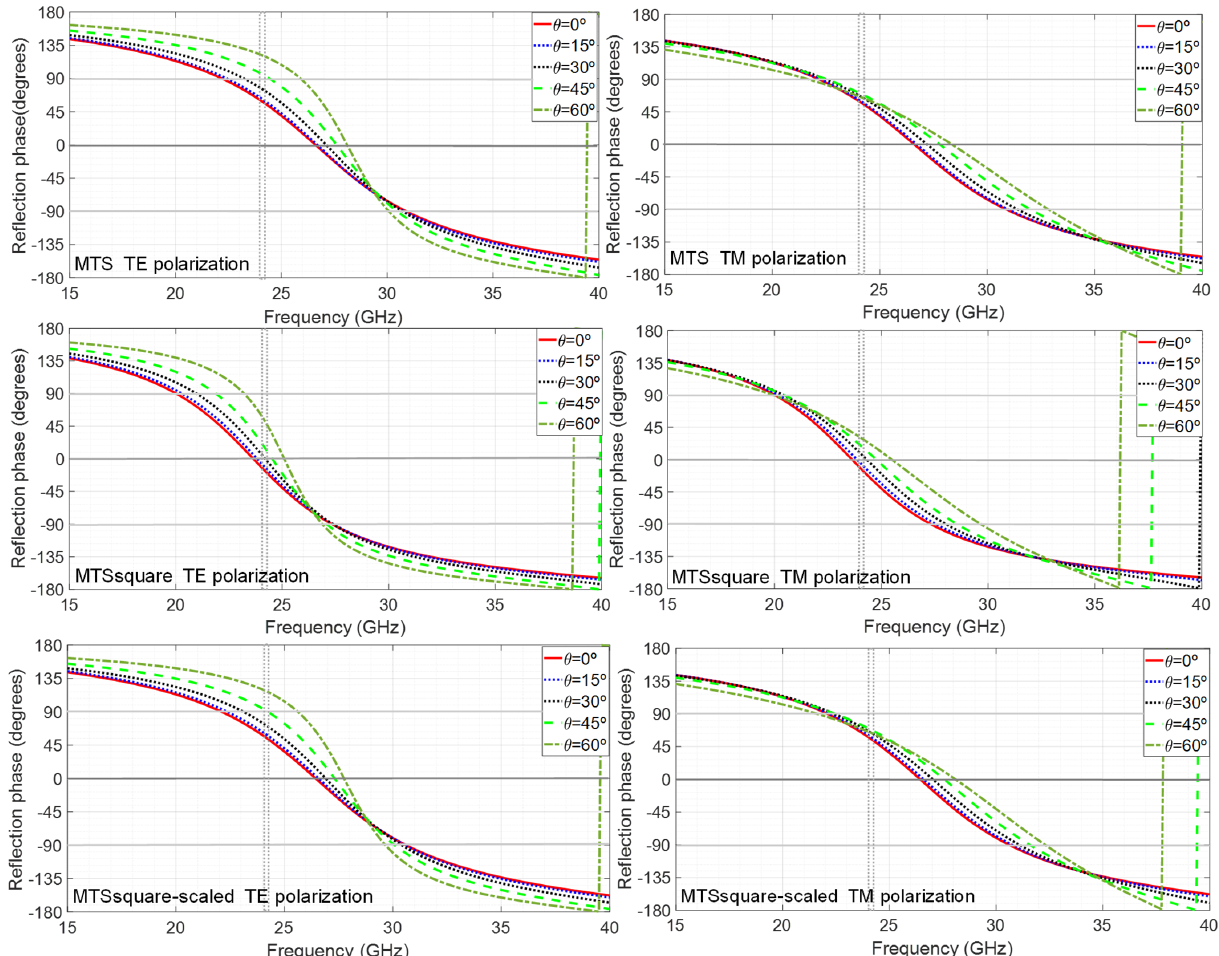
Figure 3. Simulation results of metasurfaces’ reflection coefficient phase for TE and TM polarization under different incidence angles θ = 0 ◦ , 15 ◦ , 30 ◦ , 45 ◦ and 60 ◦ corresponding to a ϕ = 45 ◦ polarization angle of the incident fi eld.